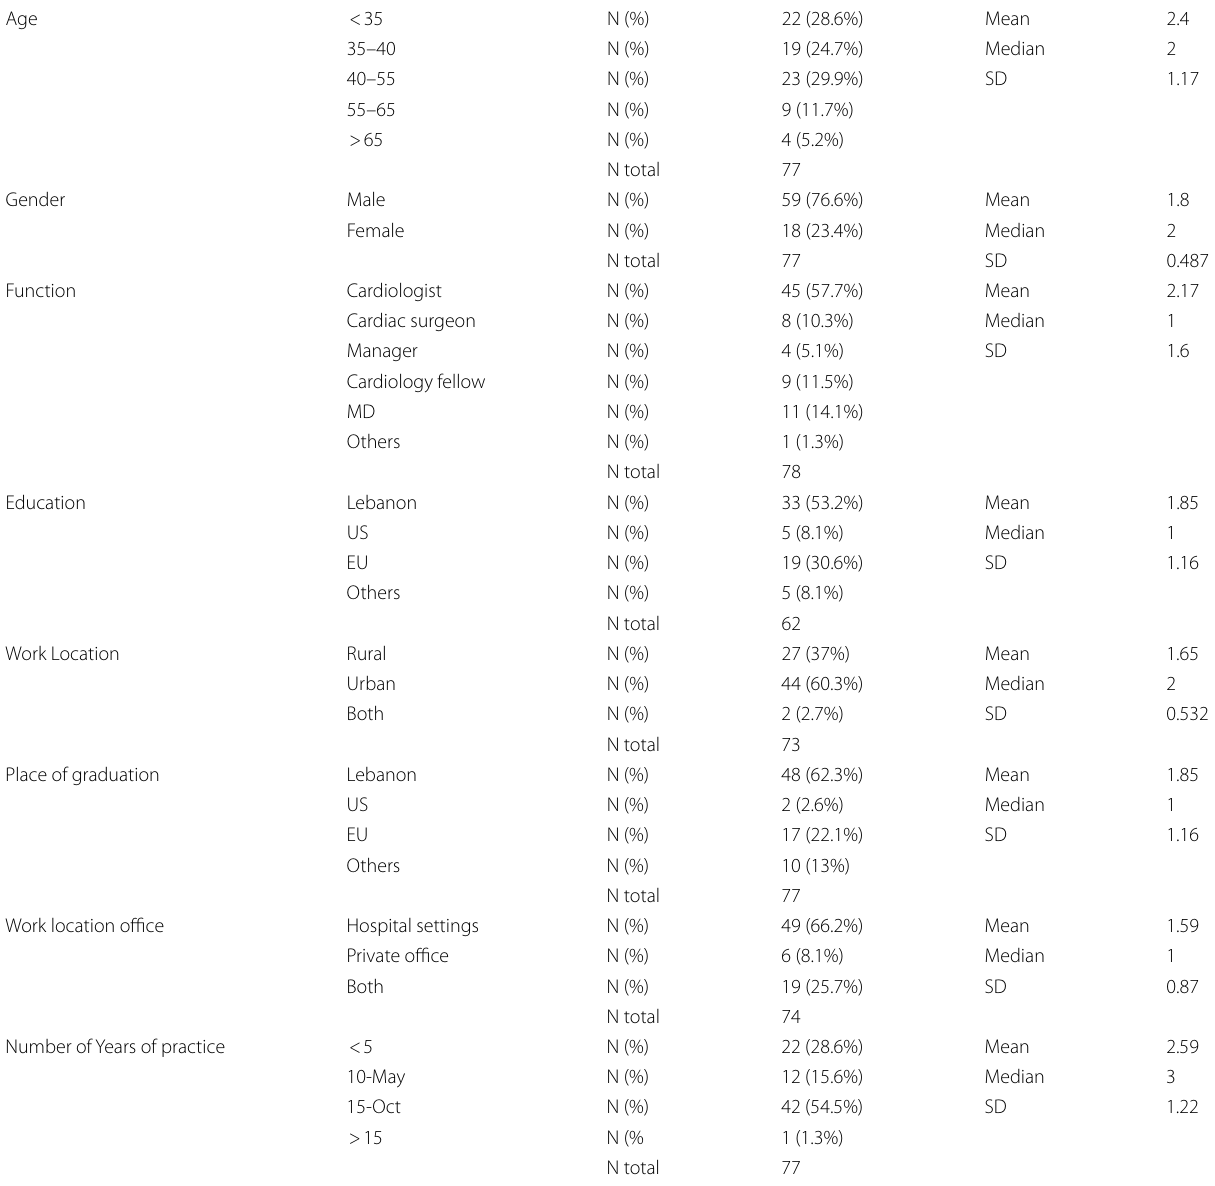
Table 1 Socio–demographic characteristics of the